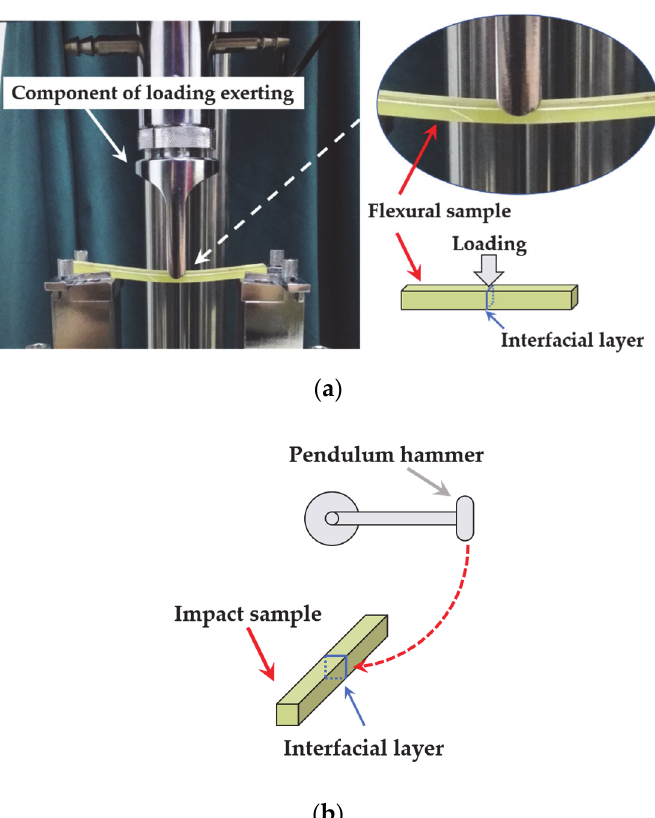
Figure 1. Photo of the arrangement in flexural test and impact test of the sample with laminated interface: ( a ) the test of flexural strength; ( b ) the test of impact strength. The load was applied on the interfacial region during the test of flexural strength and impact strength.